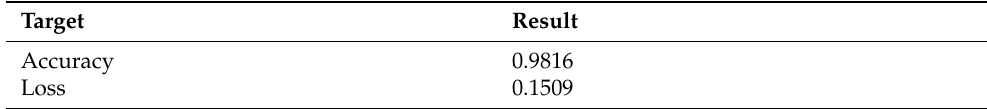
Table 7. ANN classifies the optimal results.